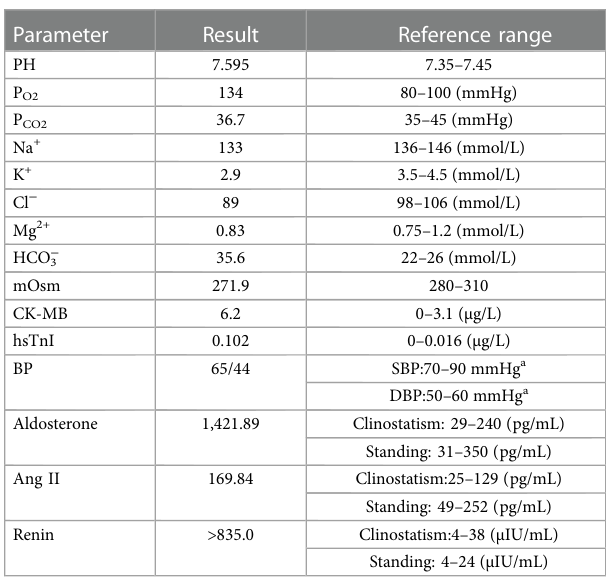
TABLE 1 Laboratory fi ndings of the patient.